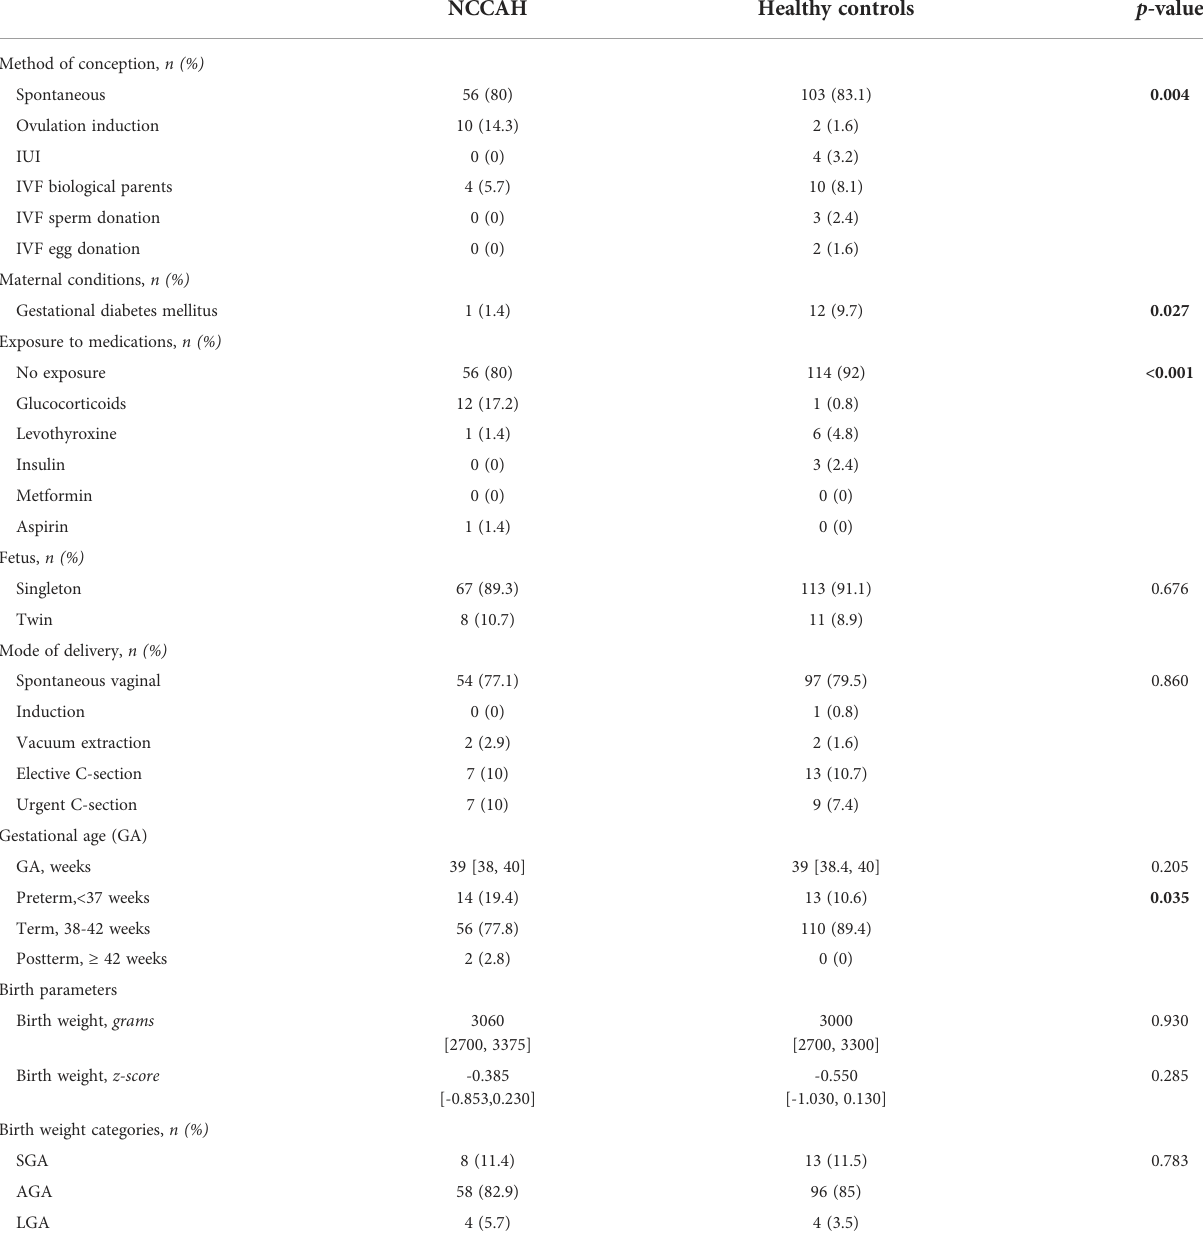
TABLE 2 Pregnancy and perinatal characteristics of the NCCAH group and their healthy controls. NCCAH Healthy